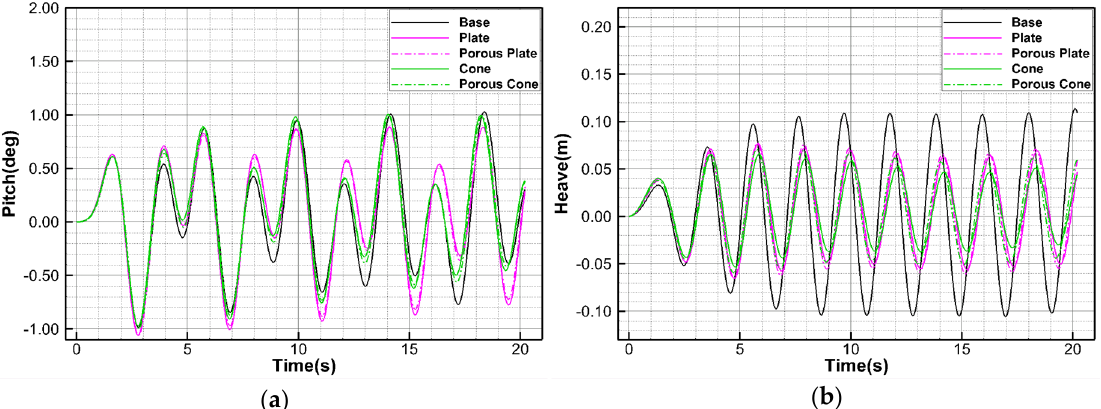
Figure 19. Time histories of ( a ) pitch and ( b ) heave motions of the buoys in regular waves, for which the frequency is the same as the heave natural frequency of the Base model, estimated by CFD simulation.